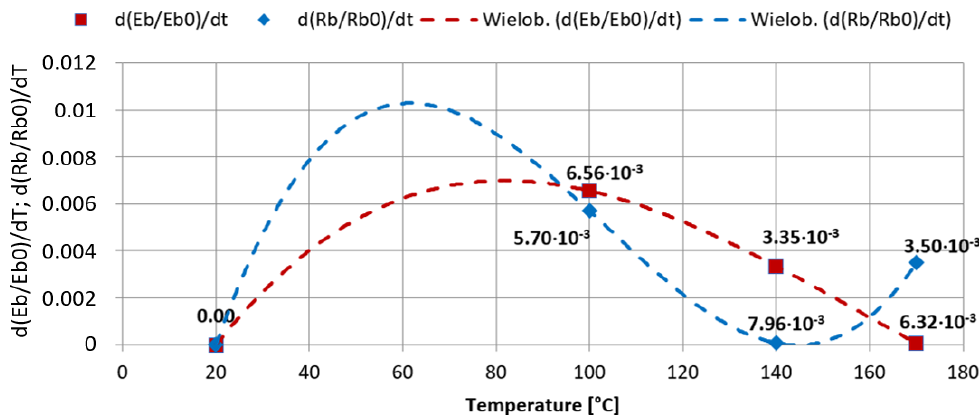
Figure 14. Results of testing the speed of damage of bending strength and elastic modulus depending on a temperature value.